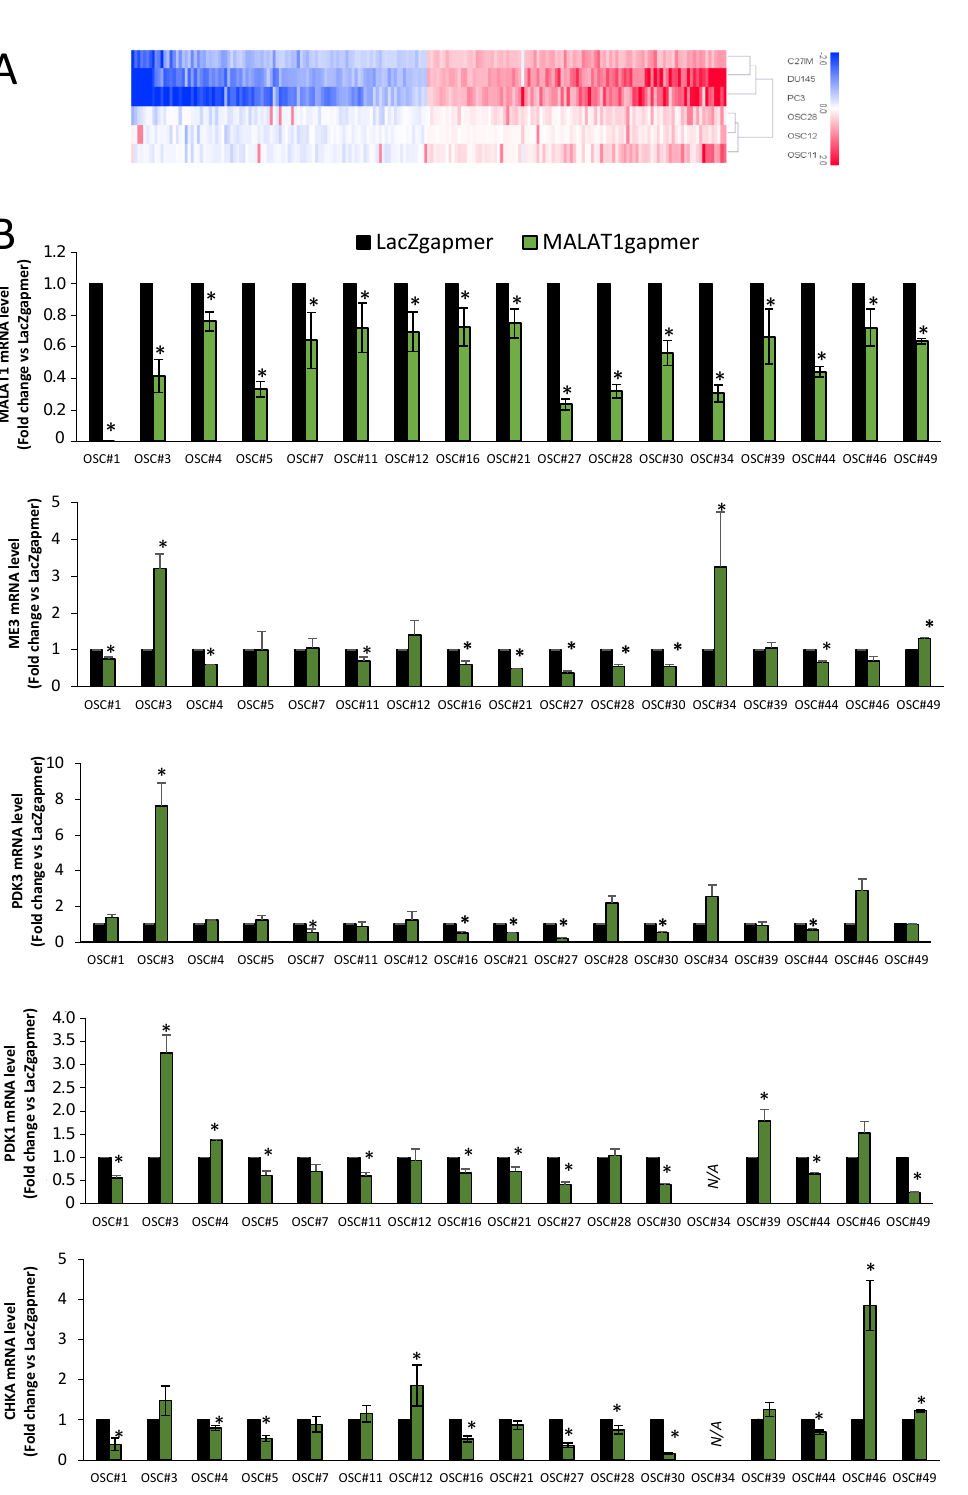
Figure 9. Validation of array data in organotypic slice cultures (OSCs). ( A ) Heatmap of concordant genes ( n = 200) sharing the same regulation after MALAT1 depletion in PCa cells (C27IM, DU145, and PC3) and OSC#28-12-11. Mean log2FC are represented with red stripes for upregulated genes and blue for downregulated genes. ( B ) Validation of MALAT1, ME3, PDK3, and PDK1 and CHKA as representative genes emerged from array analysis before (white bars) and after (green bars) MALAT1 depletion in different OSCs. Data are expressed as fold change vs. LacZgapmer (mean ± SEM). * p < 0.05 MALAT1gapmer vs.